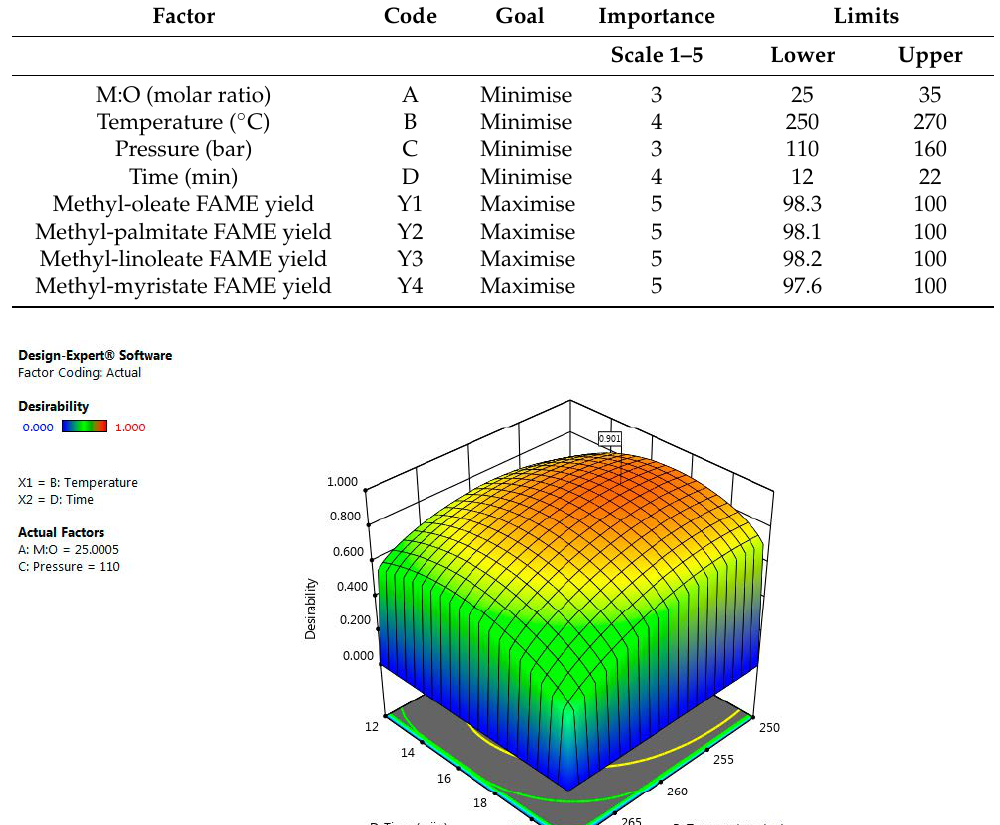
Table 6. Experimental design variables and their coded levels.